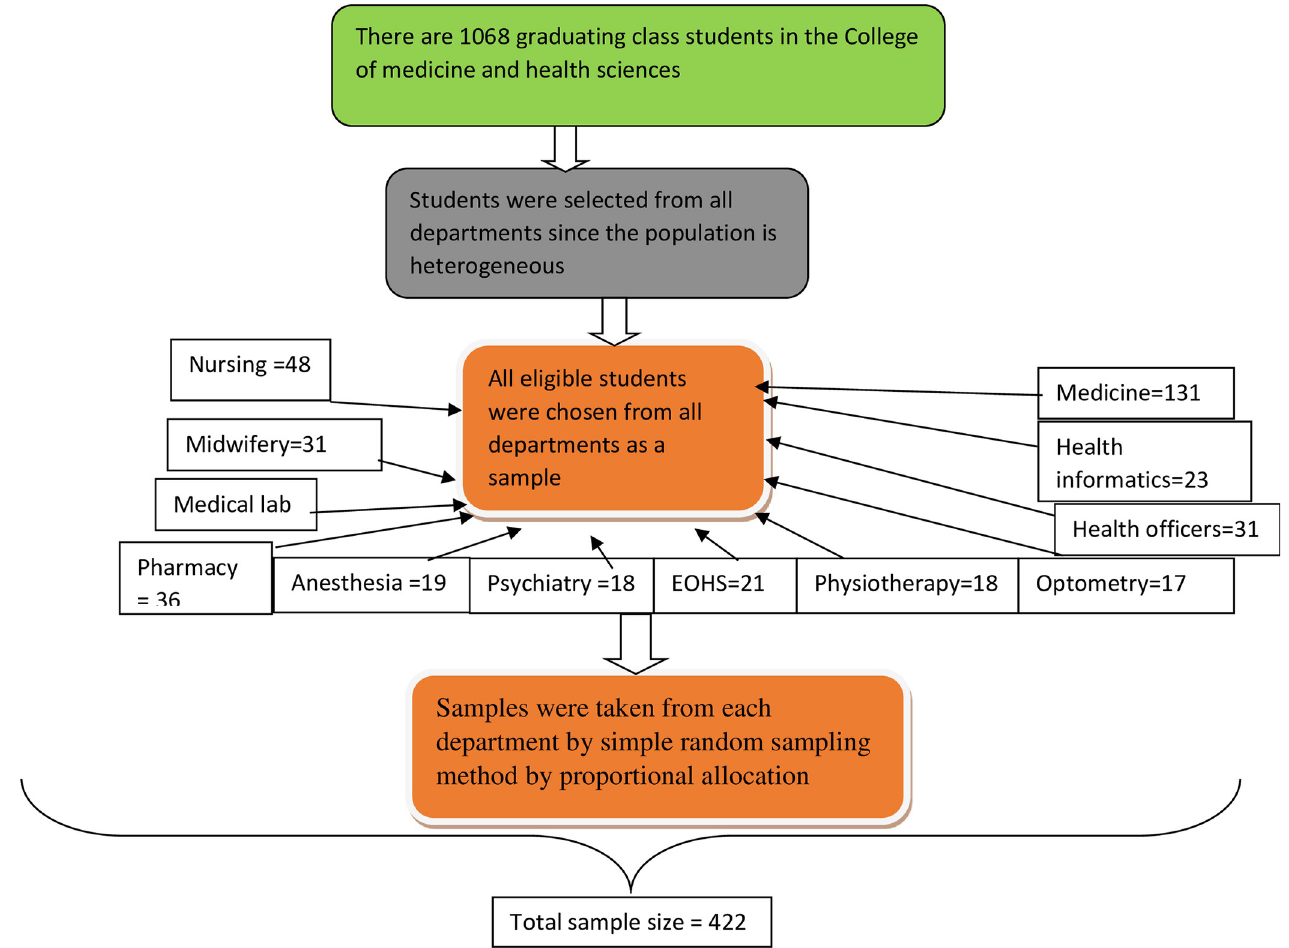
Fig 1. Schematic presentation of the sampling procedure for the study done on willingness to work in rural areas and associated factors among graduating health students at the University of Gondar,